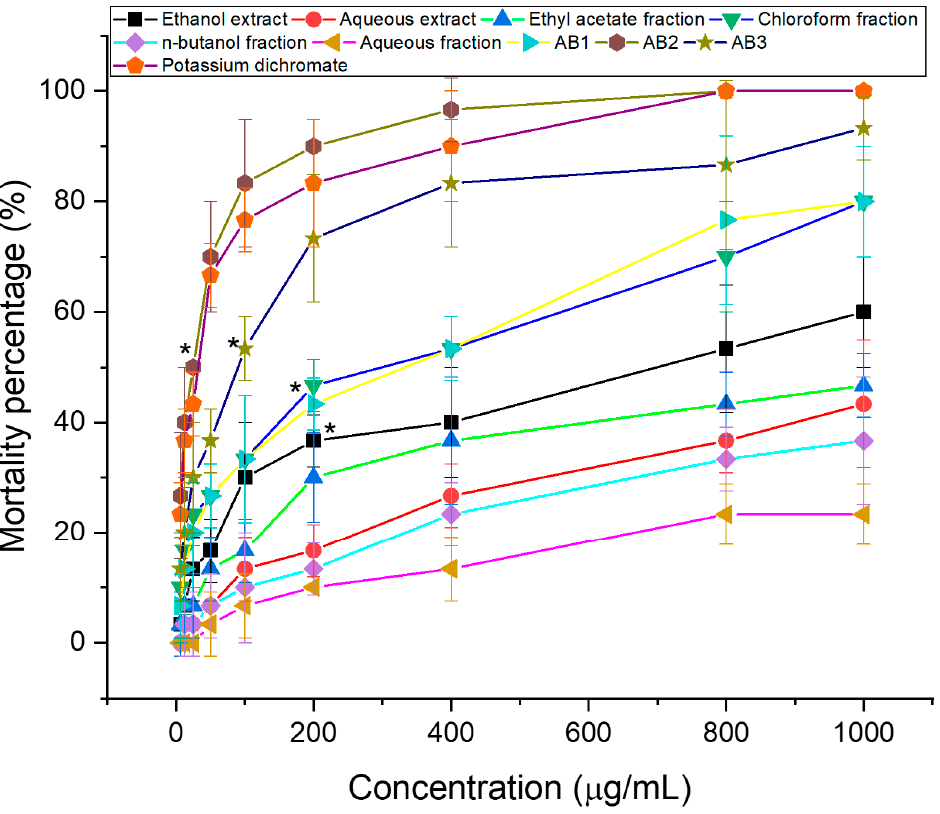
Figure 1. Brine shrimp lethality of extracts, fractions (A), and isolated compounds (B) at 24 h, *mean significant difference ( p < 0.05) compared to control. Table 1. Brine shrimp toxicity expressed as LC 50